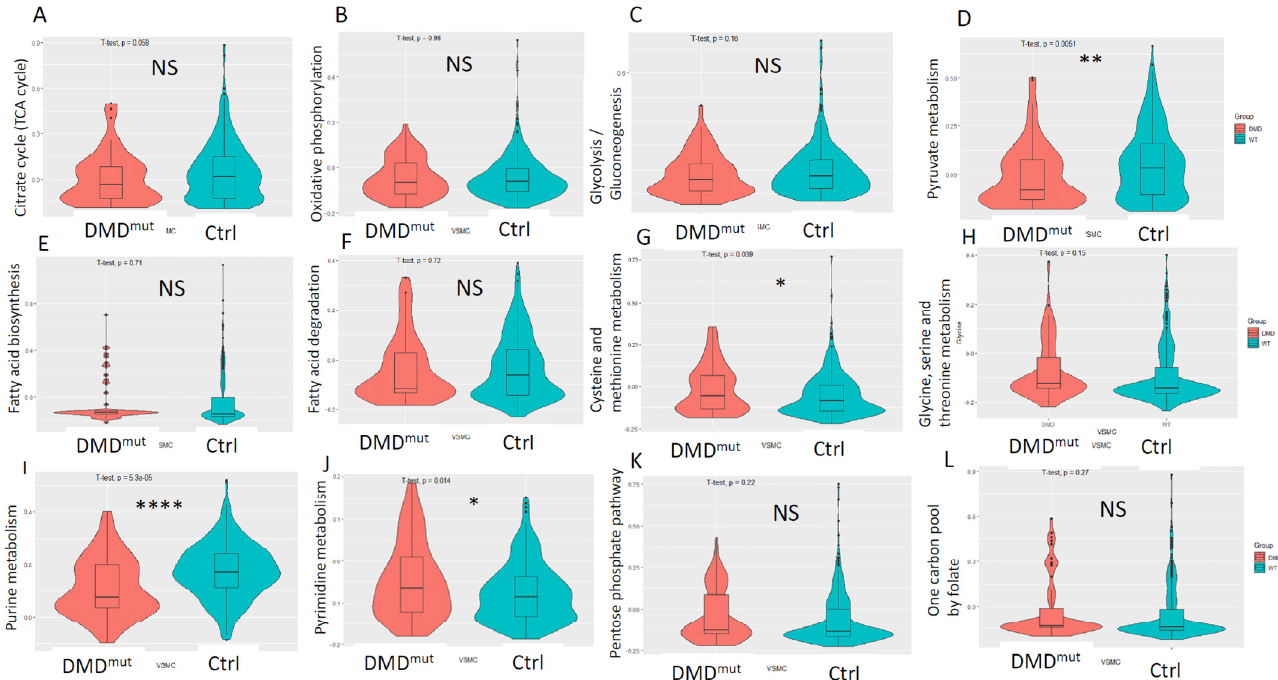
Figure 5. Violin plot illustrations of the metabolic pathway analyses performed by scMetabolism package for VSMCs from DMD mut and control muscles. Violin plots comparing citrate cycle (TCA cycle) ( A ), oxidative phosphorylation ( B ), glycolysis/gluconeogenesis ( C ), pyruvate metabolism ( D ), fatty acid biosynthesis ( E ), fatty acid degradation ( F ), cysteine and methionine metabolism ( G ), glycine, serine and threonine metabolism ( H ), purine metabolism ( I ), pyrimidine metabolism ( J ), pentose phosphate pathway ( K ), and one carbon pool by folate ( L ) (NS: no significant difference, * p < 0.05, ** p < 0.01, **** p < 0.0001, n = 66 for DMD mut VSMCs, n = 336 for control VSMCs).